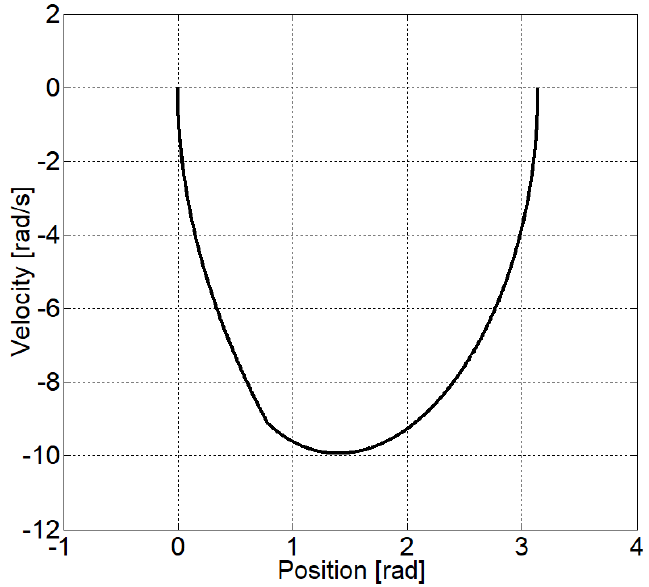
Figure 5. State trajectory with the input constraint.